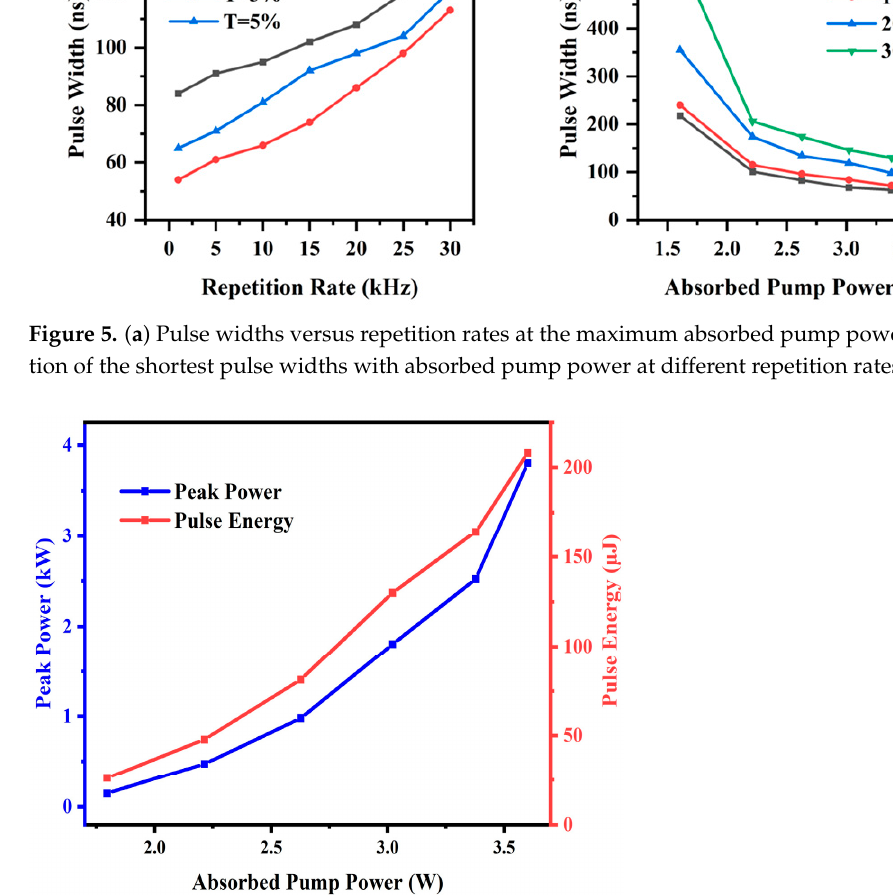
Figure 6. The dependences of pulse energy and pulse peak power on the absorbed pump power at T = 3%.